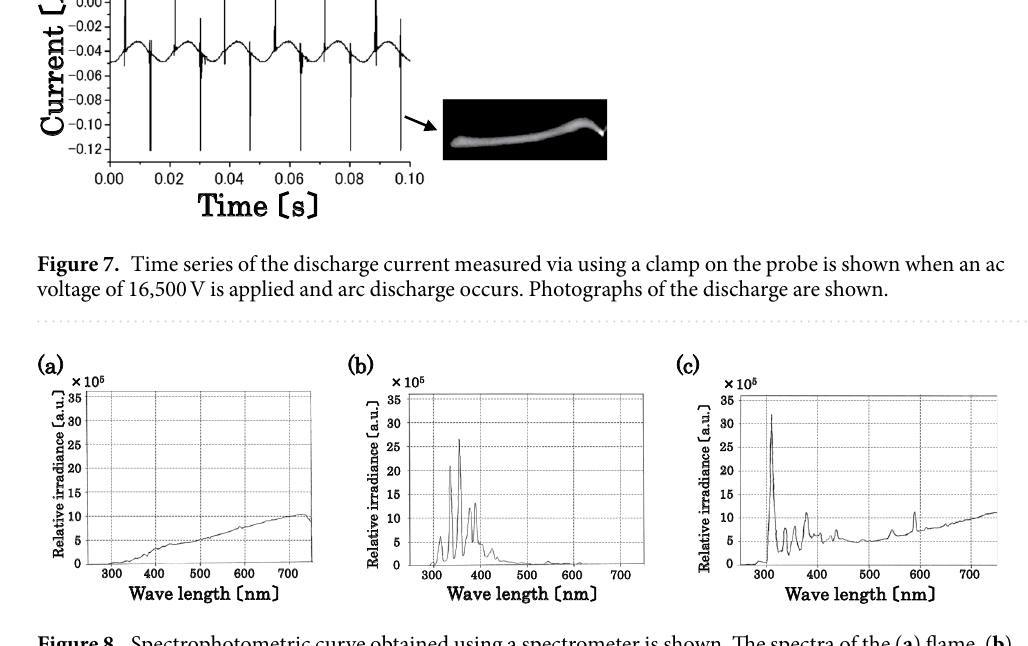
Figure 8. Spectrophotometric curve obtained using a spectrometer is shown. The spectra of the ( a ) flame, ( b ) arc discharge, and ( c ) flame and arc plasma under the arc discharge, are